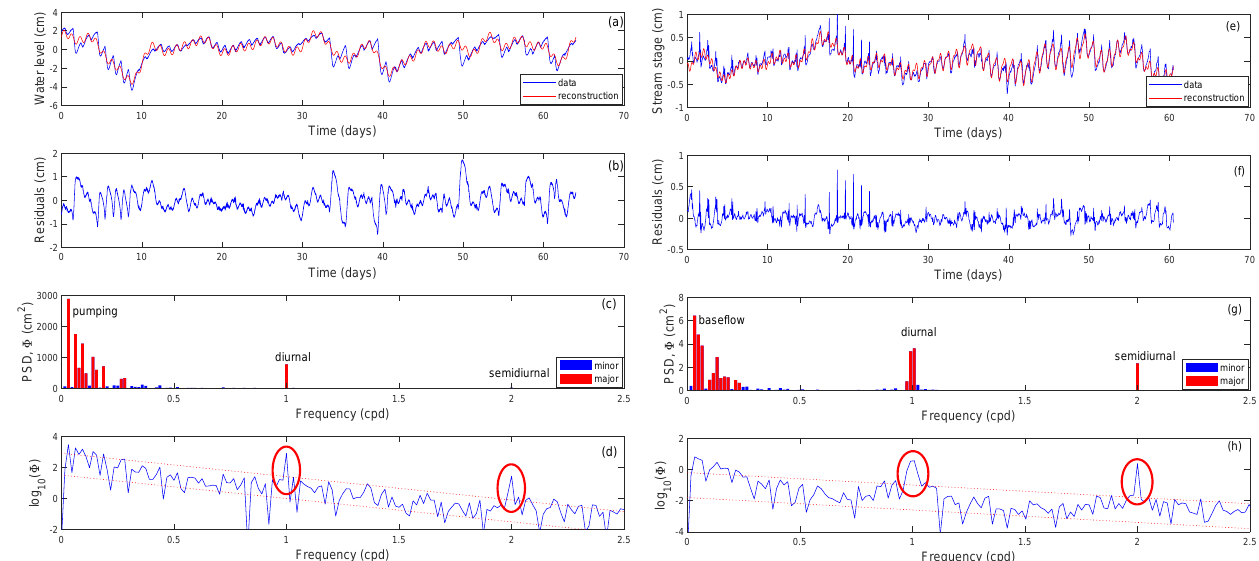
Figure 12. Spectral analysis of piezometer ( a – d ) and the stream stage ( e – h ) water level time series, where ( a , e ) show water level fluctuations with the mean removed (blue) and filtered (red), ( b , f ) time series of residuals (data minus reconstructed signal), ( c , g ) power spectra with frequencies where Φ (PSD) exceeds Φ 0 marked in red, and ( d , h ) power spectra plotted on semi-log scale to highlight diurnal and semi-diurnal frequencies (red circles). Φ 0 = 3 × 10 2 cm 2 for RP1 and Φ 0 = 0.5 cm 2 for the stream stage. The dotted red lines in ( d , h ) are 95% confidence intervals based on linear trend and constant